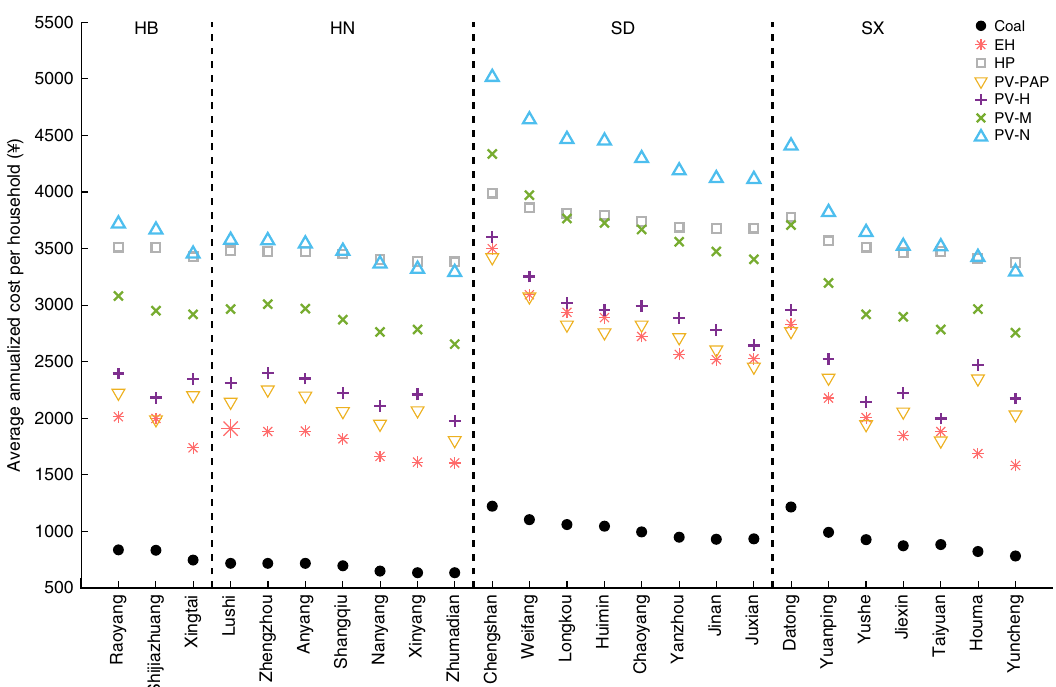
Fig. 5 Average annualized cost per household in different cities in Northern China. “ Coal ” represents that a rural household burns raw coal for space heating in winter. “ EH ” and “ HP ” represent that a rural household uses an 8-kW electric heater and heat pump, respectively. “ PV-PAP ” , “ PV-H ” , “ PV-M ” , and “ PV-N ” represent that a rural household uses solar-powered electric heating with a 3-kW solar panel and 8-kW electric heater, and the subsidies for solar energy are 0.42, 0.37, 0.18, and 0 ¥/kWh, respectively. Note that “ PAP ” , “ H ” , “ M ” , and “ N ” are short for poverty alleviation program, high-level subsidy, medium-level subsidy and no